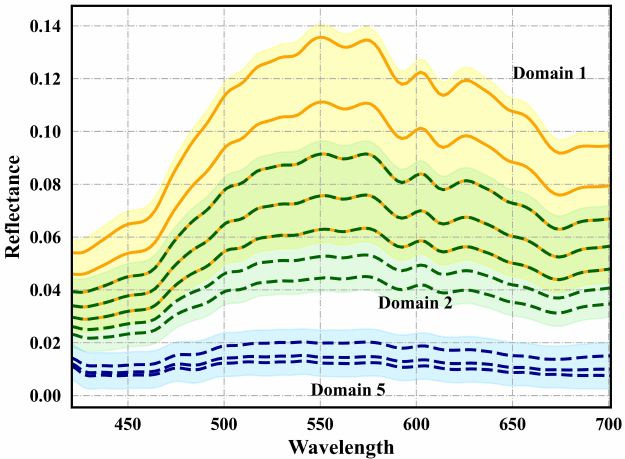
Figure 12. Part of the synthetic data